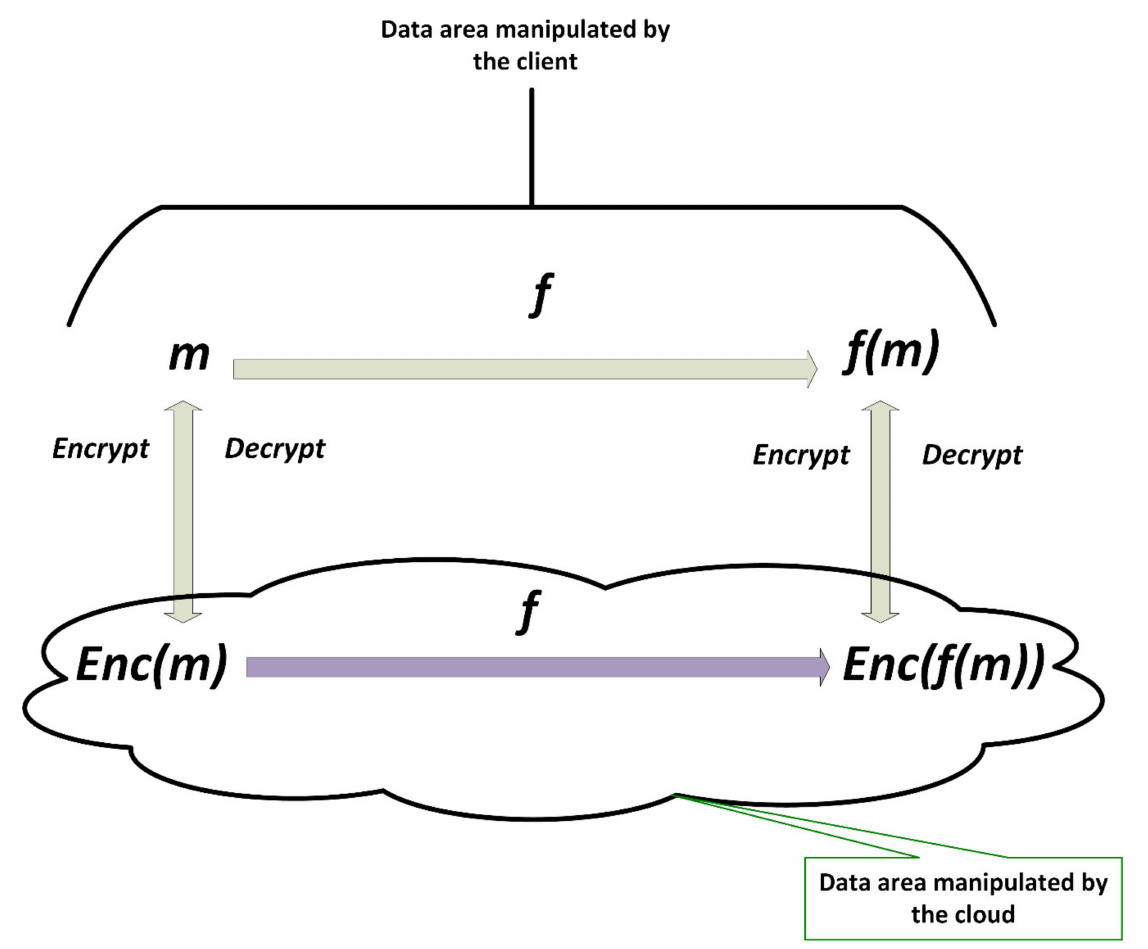
Figure 1. Fully Homomorphic Encryption